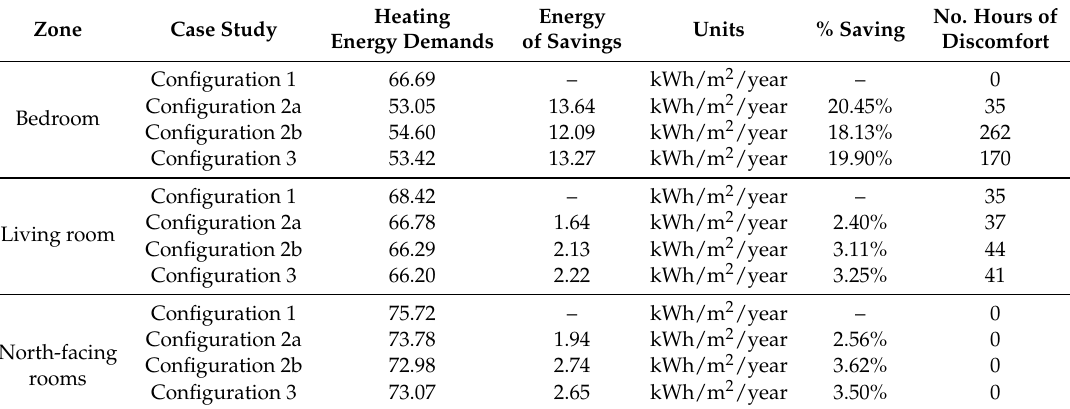
Figure 20. Comparison of temperatures in the living room and north-facing rooms for the case of the bedroom fitted with the PCM and mortar solar Trombe walls. Table 8. Comparison of the one-year heating energy demands, one-year energy savings and number of hours of temperature discomfort inside the bedroom, living room and north-facing rooms specific to the studied